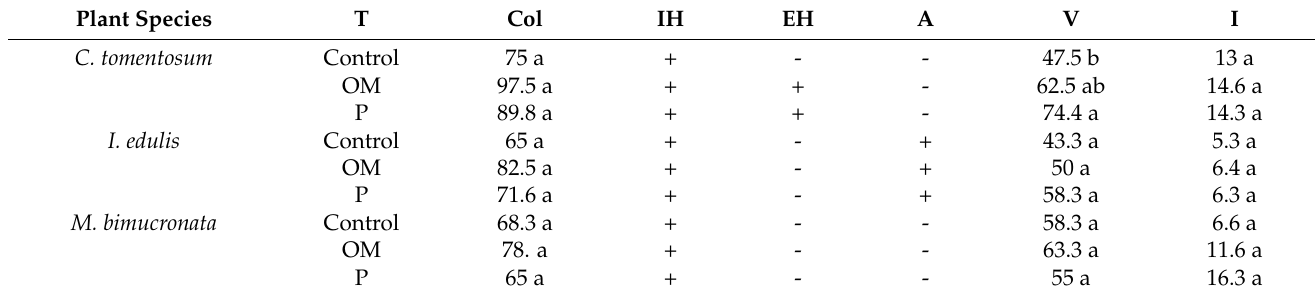
Table 2. Root colonization. References = Col: Percentage of AM root colonization, IH: non-septate intercellular hyphae, EH: non-septate extraradical hyphae, A: arbuscules, V: vesicles, I: intensity of colonization, +: presence, -: absence, T: Treatments, OM: organic matter treatment, P: fertilized with natural rock phosphate, and control treatments. Values follow by the same lowercase letter do not differ by p < 0.05, using Tukey test.